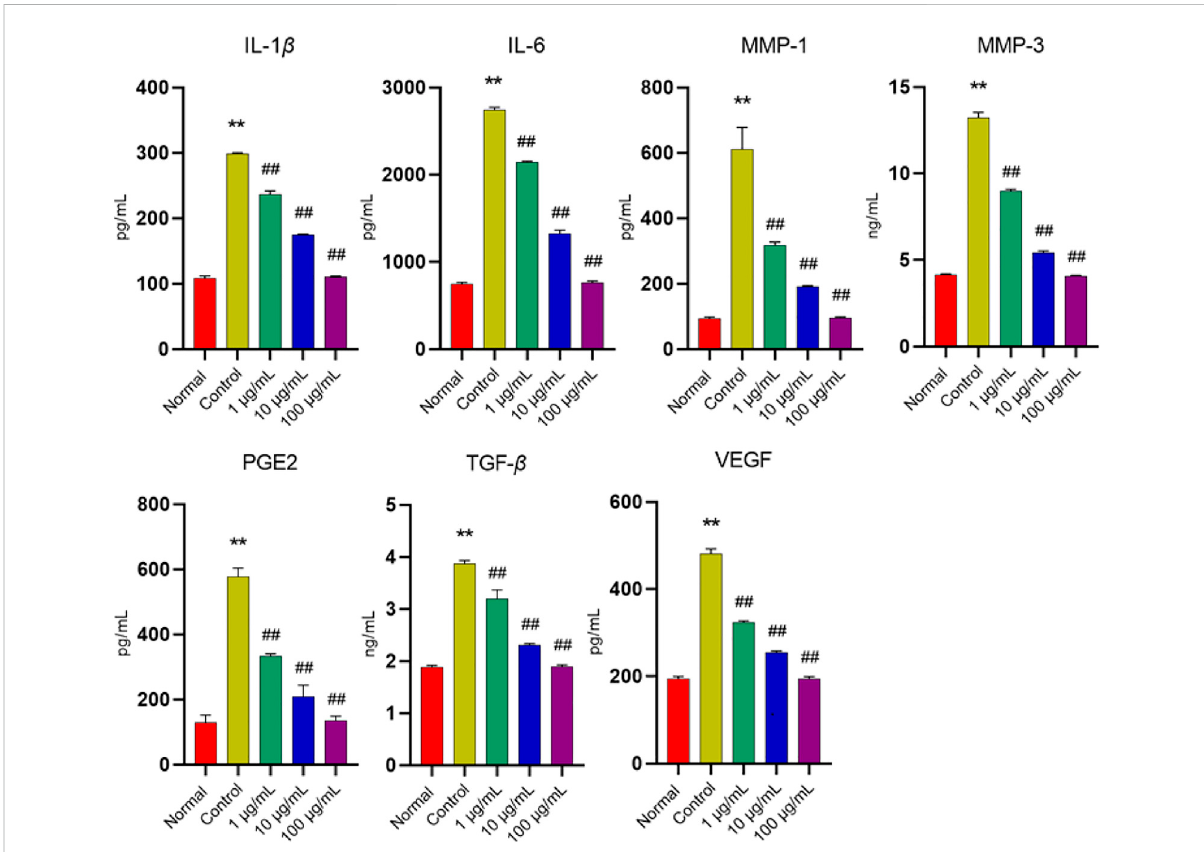
The effects of FTAs on the contents of IL-1 β , IL-6, MMP-1, MMP-3, PGE2, TGF- β and VEGF in TNF- α -induced MH7A cells. MH7A cells were intervened by corresponding concentrations of FTAs in absence or presence of 20 ng/ml TNF- α for 24 h, and then the levels of the